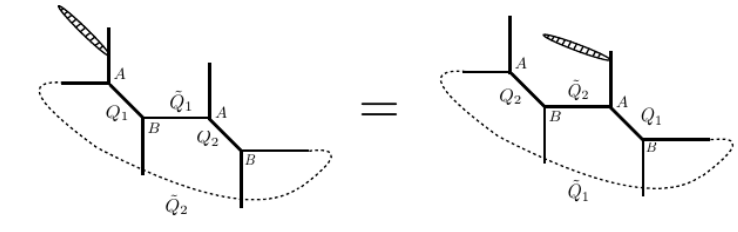
Figure 9: The relation of web diagrams 1 (cid:13) and 3 (cid:13)